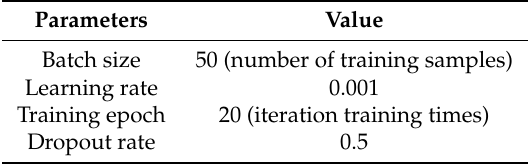
Table 2. Summary of parameters used in deep-learning classifier.